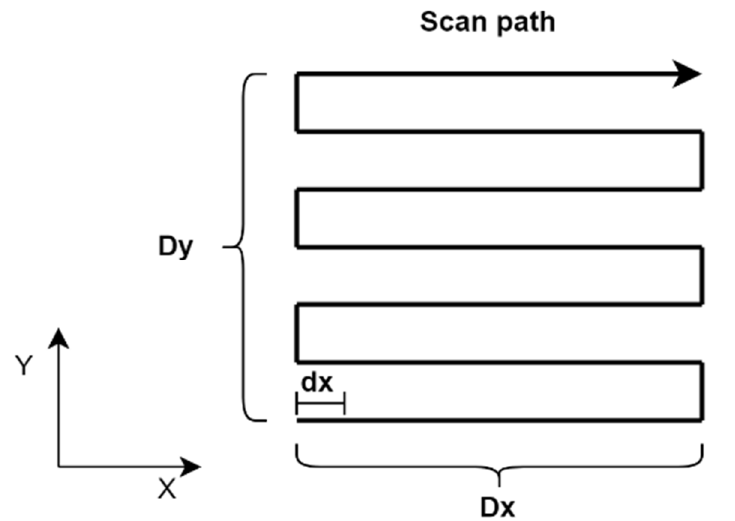
Figure 3. Z scanning